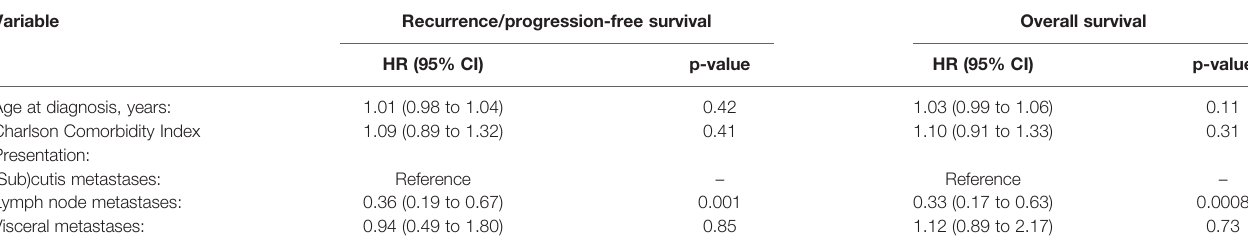
TABLE 4 | Multivariable analysis of overall